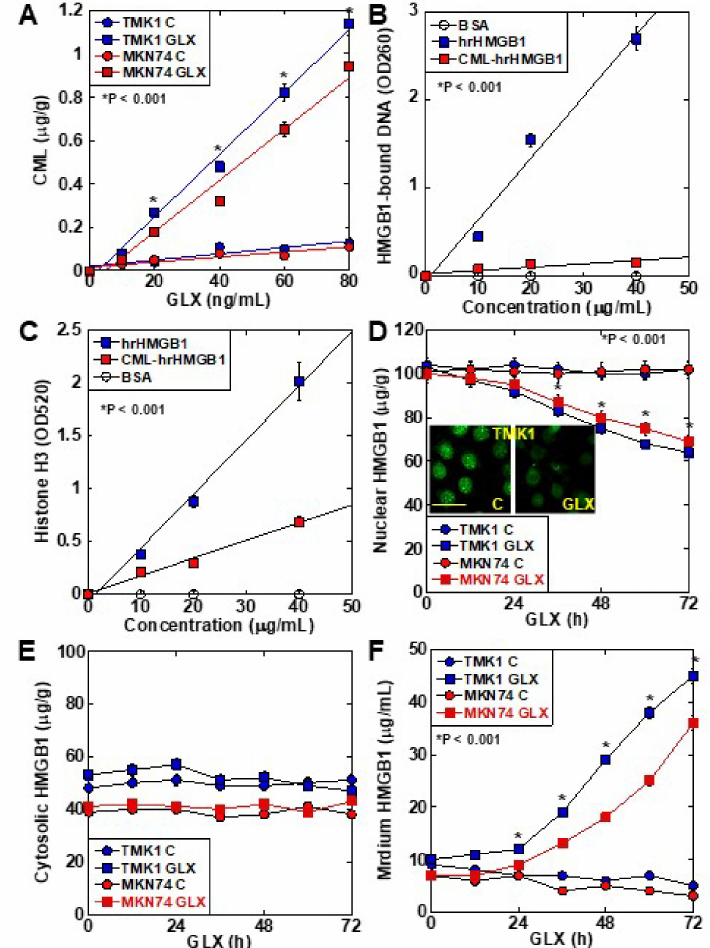
Figure 2. Properties of CML formation in HMGB1 in TMK-1 gastric cancer cells. ( A ) CML formation in GLX-treated TMK-1 cells measured using ELISA. ( B ) Effect of glycation on DNA binding of HMGB1 in TMK-1 cells treated with HMGB1 or GLX (CML-HMGB1). DNA extracted from the nuclear protein immunoprecipitated by HMGB1 antibody was measured using a spectrophotometer (A 260 ). ( C ) Effect of glycation on histone H3 binding to rhHMGB1 or CML-rhHMGB1. rhHMGB1 or GLX-treated rhHMGB1 (CML-HMGB1) were mixed with FITC-labeled histone H3. Histone H3 was measured using a fluorescence microplate reader (A 520 ). ( D – F ) HMGB1 in the nuclear fraction ( D ), cytosol ( E ), and cultured medium ( F ) measured by ELISA in GLX-treated TMK-1 cells. The inset of panel D shows the fluorescent immunocytochemistry of HMGB1. Scale bar, 50 µ m. Error bar and standard deviation calculated by ordinary analysis of variance from three independent